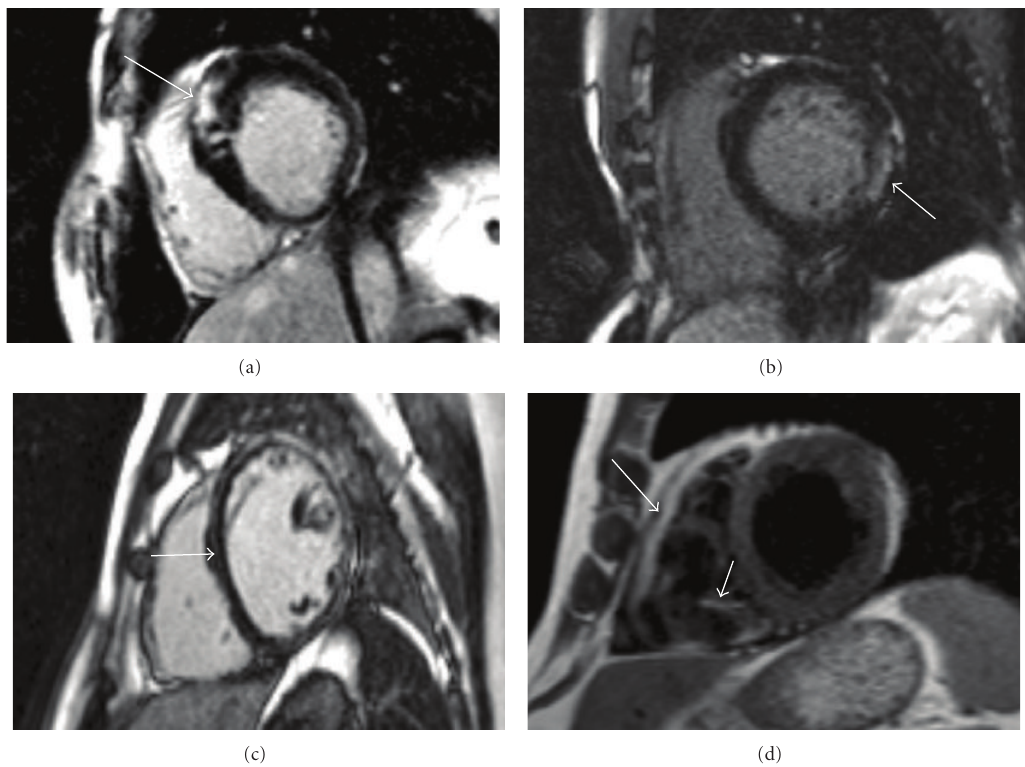
Figure 4: Tissue characterisation in inherited cardiomyopathy. (a) Patchy anteroseptal wall LGE in HCM; (b) Basal inferolateral wall LGE in Anderson Fabry Disease; (c) Septal and anterior mid wall LGE in familial FDCM; (d) RV fatty replacement in ARVC on the trabeculae and possibly the free